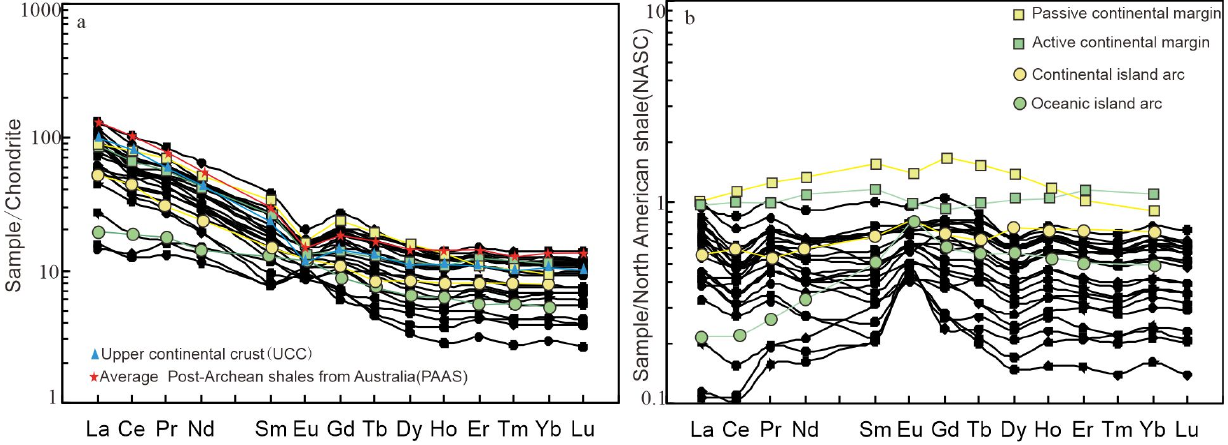
Figure 5. Chondrite-normalized ( a ) and NASC-normalized ( b ) REE patterns of the Longmaxi Forma- tion in the Yanyuan